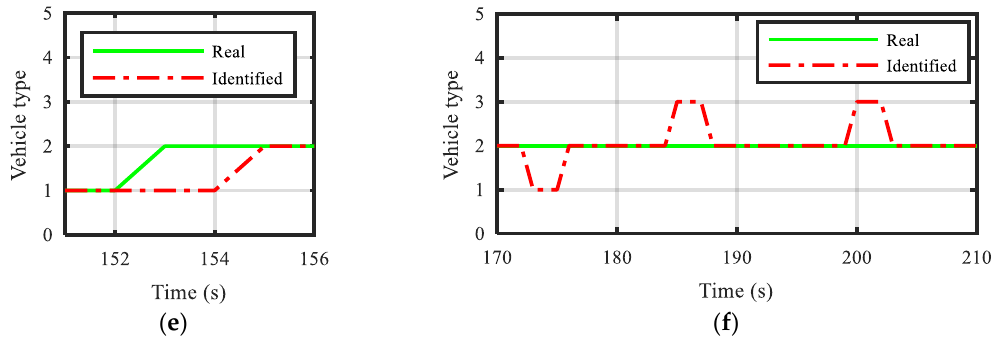
Figure 5. Typical condition test results of leading vehicle type changing. ( a ) is a full figure. ( b )–( f ) are zoomed in to the five sections of the full figure in ( a ).